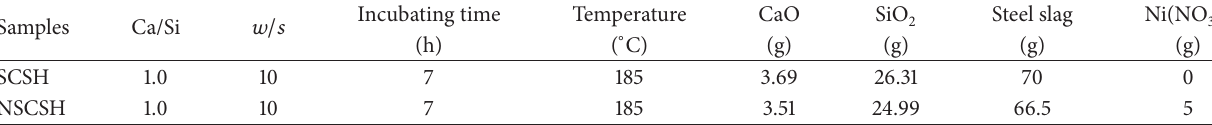
Table 3: Parameters for hydrothermal synthesis of calcium silicate hydrate from steel slag.